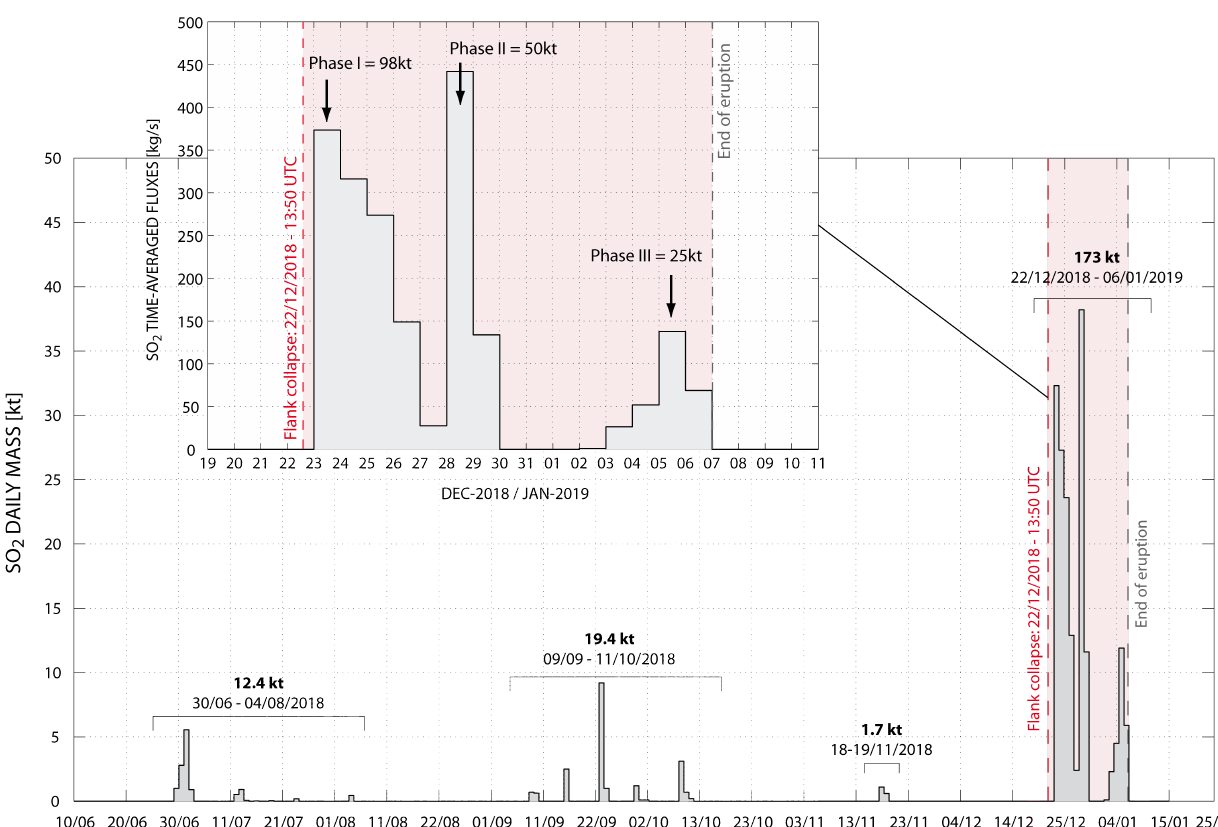
Figure 5: Daily mass of SO calculated from a combination of OMI/Aura and Suomi-NPP/OMPS satellite before 2 the collapse (10/06/2018–22/12/2018) and using Tropomi/Sentinel-5 satellite data after the collapse. Also, we provide SO time-averaged mass fluxes (in kgs − 1 ) for the post-collapse eruption (top panel) clearly showing the 2 3 di ff erent phases of post-collapse